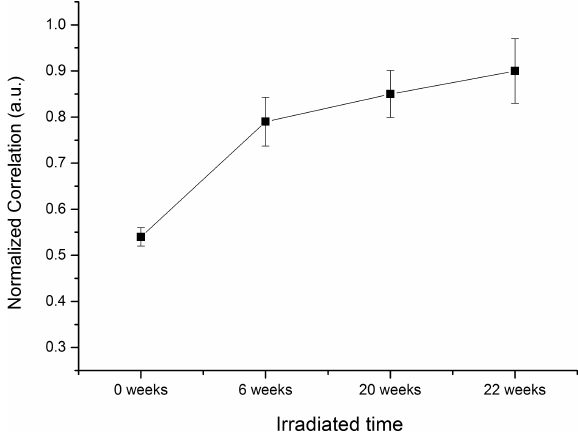
Fig. 6. The correlation at di®erent time